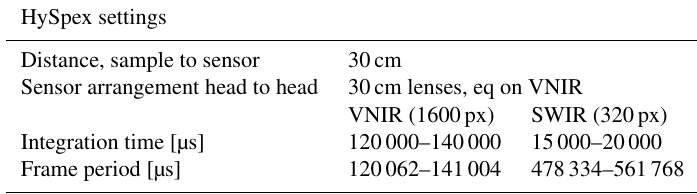
Table 3. HySpex settings for laboratory measurements of the copper-bearing minerals (Koellner et al., 2019).